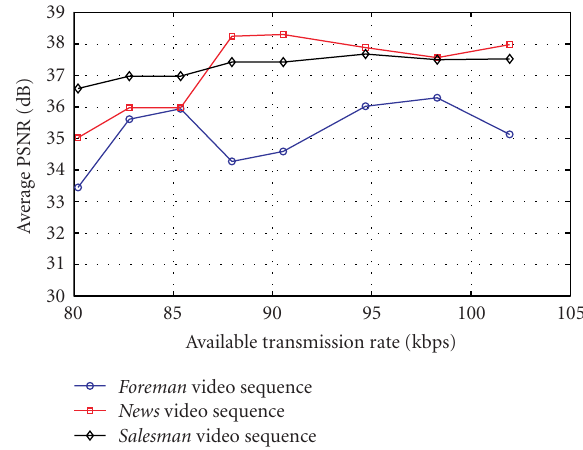
Figure 4: Average PSNR (in dB) as a function of available trans- mission rate (in kbps) for the “even-loss distribution” algorithm. Comparison between the proposed distortion model for all testing video